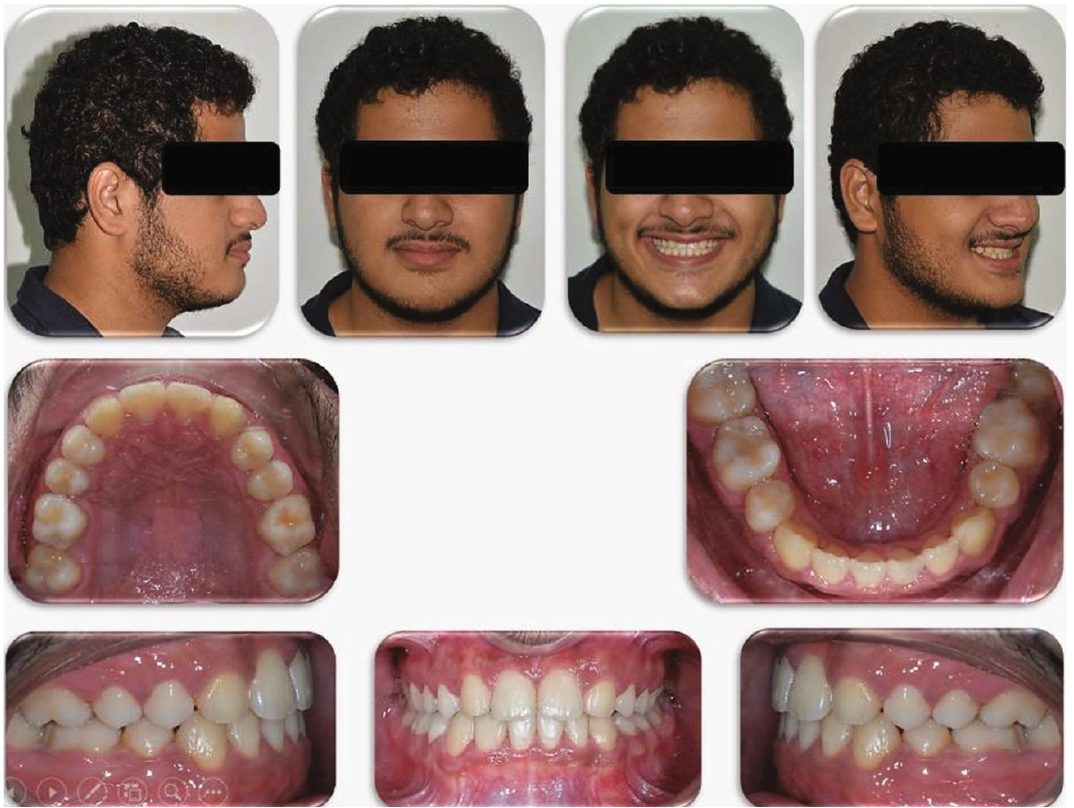
Figure 4: Posttreatment photographs of the